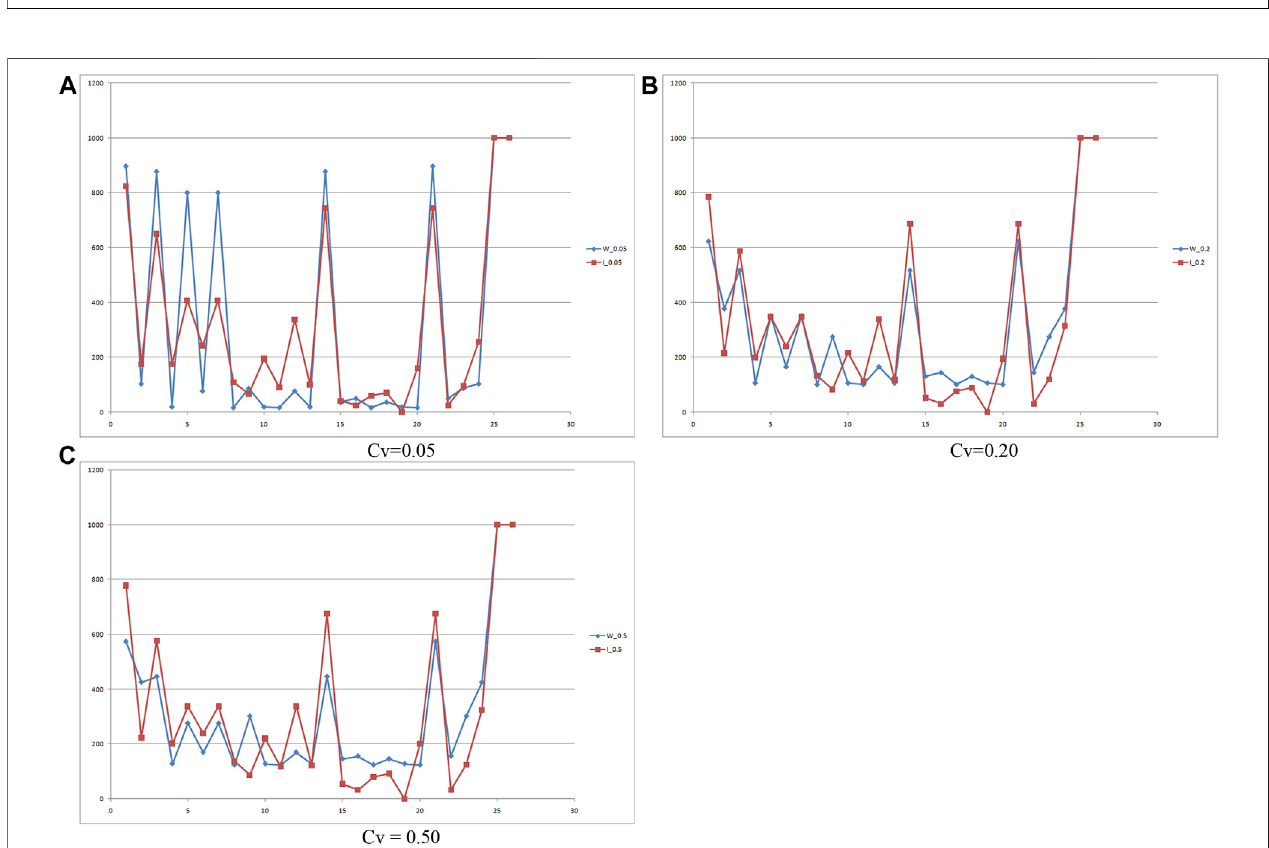
FIGURE 7 | Comparison of link fl ows for values of (A-C) Cv = 0.05, 0.20, 0.50 explicit vs. implicit weibit models.